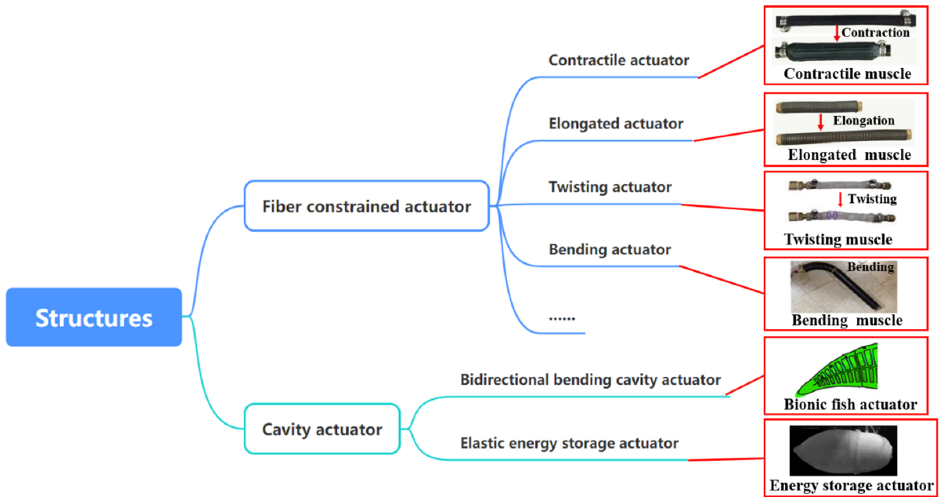
Figure 1. Configuration and structures of hydraulic powered soft actuators [19–27].